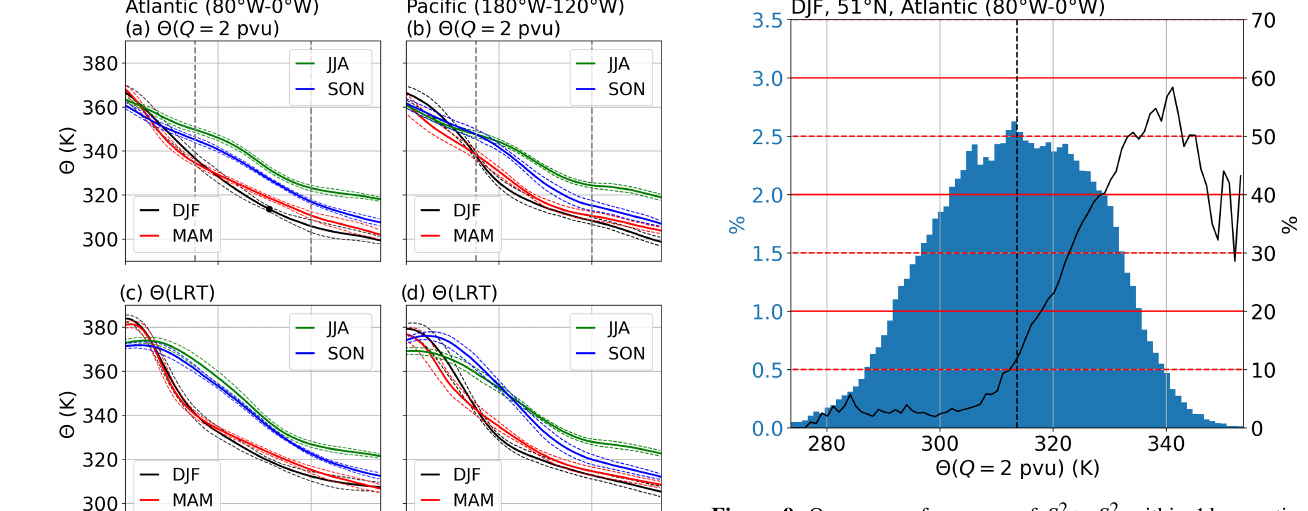
Figure 9. Occurrence frequency of S 2 ≥ S 2 t within 1km vertical distance from the LRT, depending on (cid:50)(Q = 2pvu ) . Blue his- togram shows occurrence frequency distribution of (cid:50)(Q = 2pvu ) at 51 ◦ N during DJF in 2008–2017 and averaged over 80–0 ◦ W. (cid:50)(Q = 2pvu ) in 1K bins. Dashed black line shows mean value (cid:50)(Q = 2pvu ) = 313 . 6K (black dot in Fig. 8a). Solid black line shows occurrence frequency for S 2 ≥ S 2 t between 1km below and 2km above the local LRT and within the (cid:50)(Q = 2pvu ) bins. the 10-year average background value of (cid:50)(Q = 2pvu )